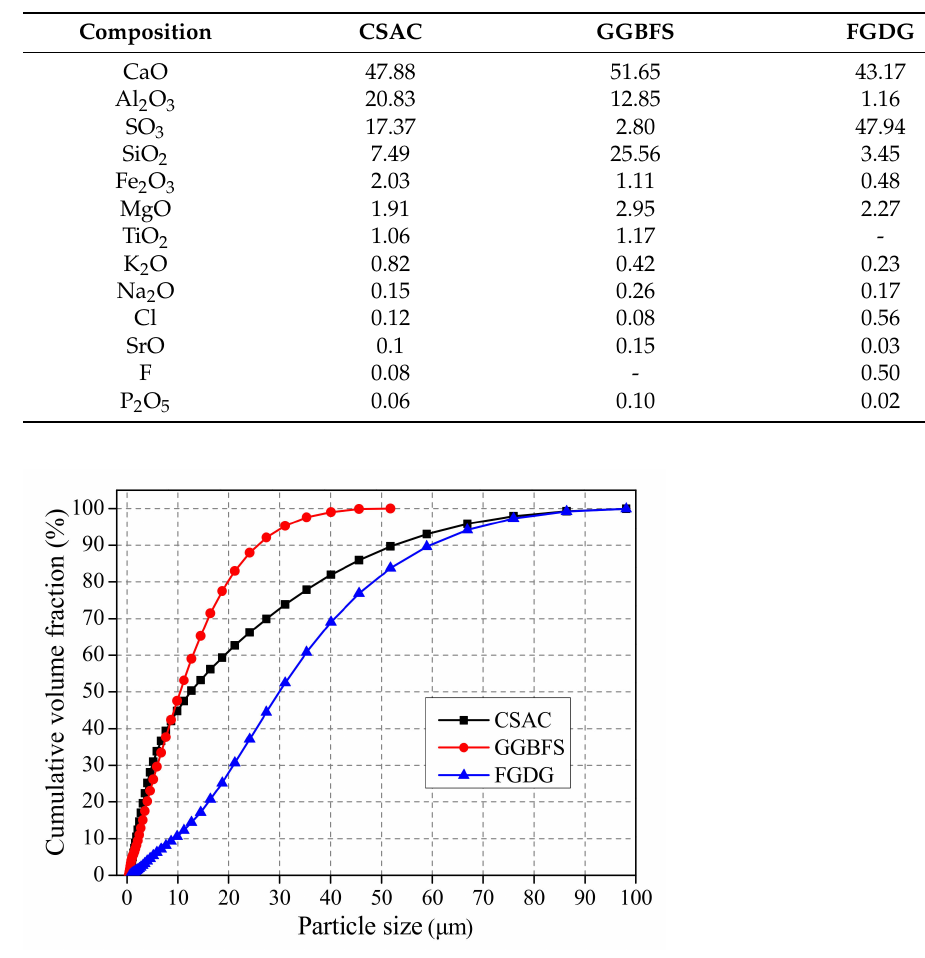
Figure 1. Particle size distribution of raw materials [18]. Four mix proportions of blended cement paste were designed, as shown in Table 2.